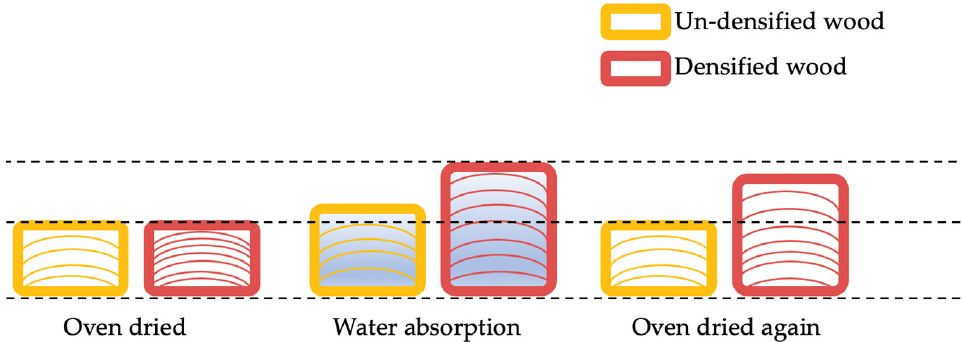
Figure 3. Schematic representation (cross-section views) of the swelling and set-recovery of un-densified and densified wood under a moistening–drying cycle.